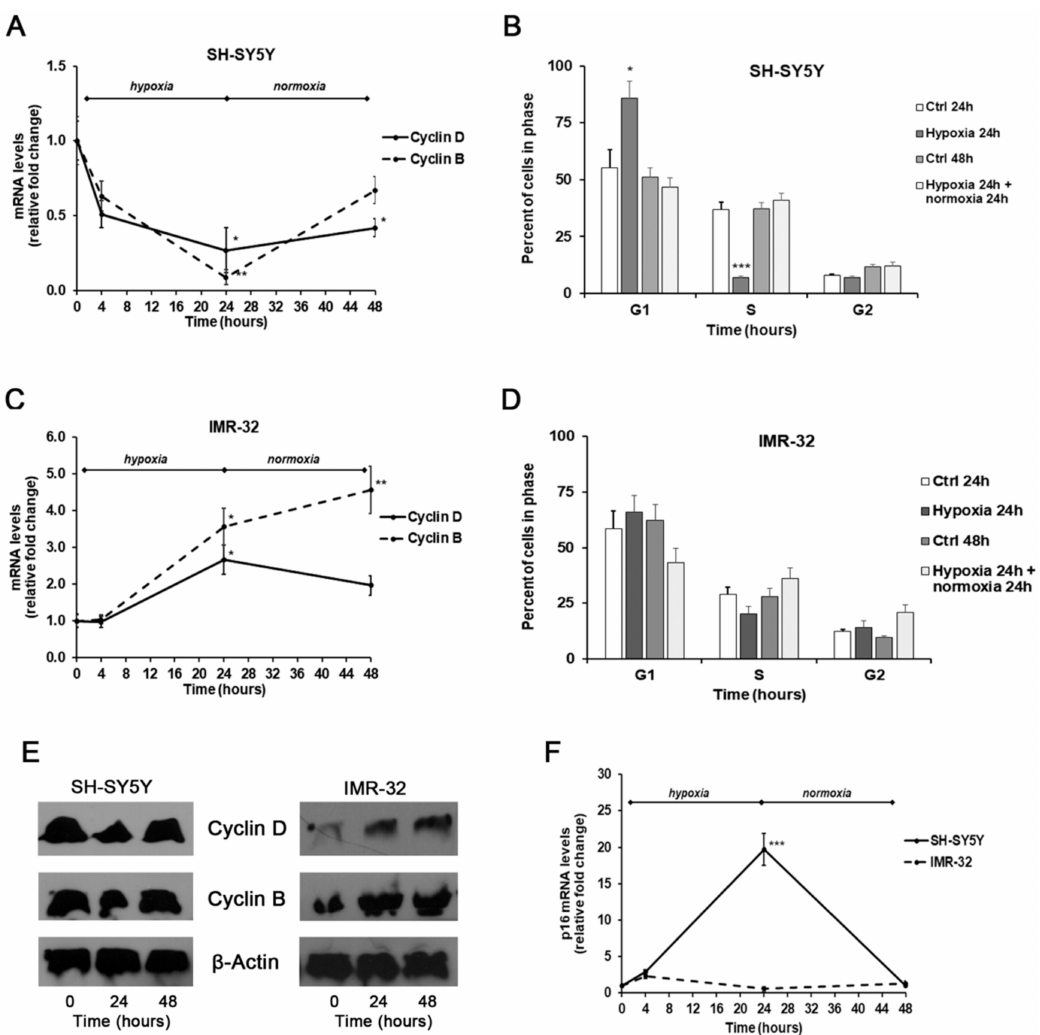
Figure 6. E ff ects of the exposure to hypoxia on cell–cycle progression. mRNA levels of cyclin D1, B1, and p16 in SH-SY5Y and IMR-32 NB cells were evaluated by Real Time-PCR ( A , C , F ). Protein levels of cyclin B1 and D1 were evaluated by Western Blotting ( E ). Cell-cycle progression in SH-SY5Y ( B ) and IMR-32 ( D ) NB cells was measured by FACS analysis. Histogram represents the percentages of cells in G1, S, and G2 / M-phases. Data are expressed as mean ± SEM. * p < 0.05, ** p < 0.01 and *** p < 0.01 significant di ff erences in comparison to